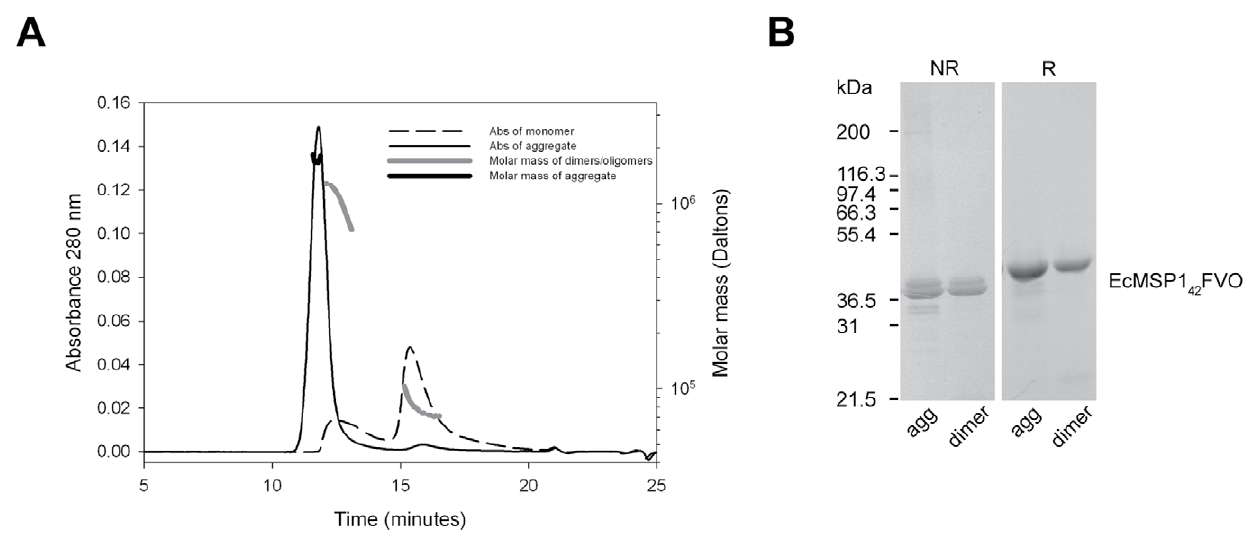
Figure 1. SEC-HPLC-MALS and Coomassie blue stained SDS-PAGE gel analysis of aggregated MSP1 42 -FVO. (A) Size exclusion chromatography with multi-angle light scattering and (B) SDS-PAGE analysis run on a 4–20% gradient Tris–glycine polyacrylamide gel under non- reducing (NR) and reducing (R) conditions.